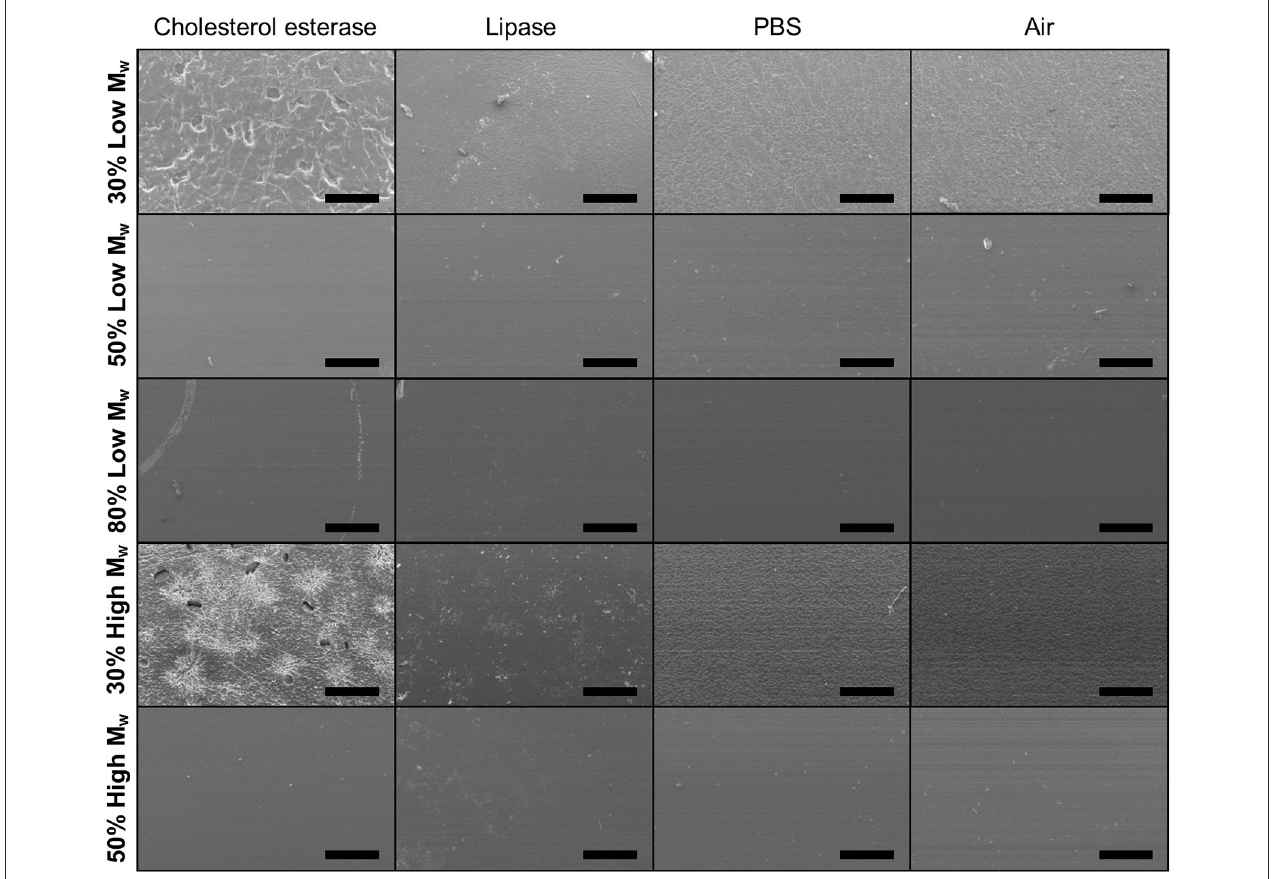
FIGURE 8 | Representative SEM images of Low and High M w and varied DM PGS-M surfaces following degradation by cholesterol esterase, lipase and PBS for 8 days. Surface erosion is clear in the 30% DM samples. Controls were PGS-M in air. Scale bars are 500 µ